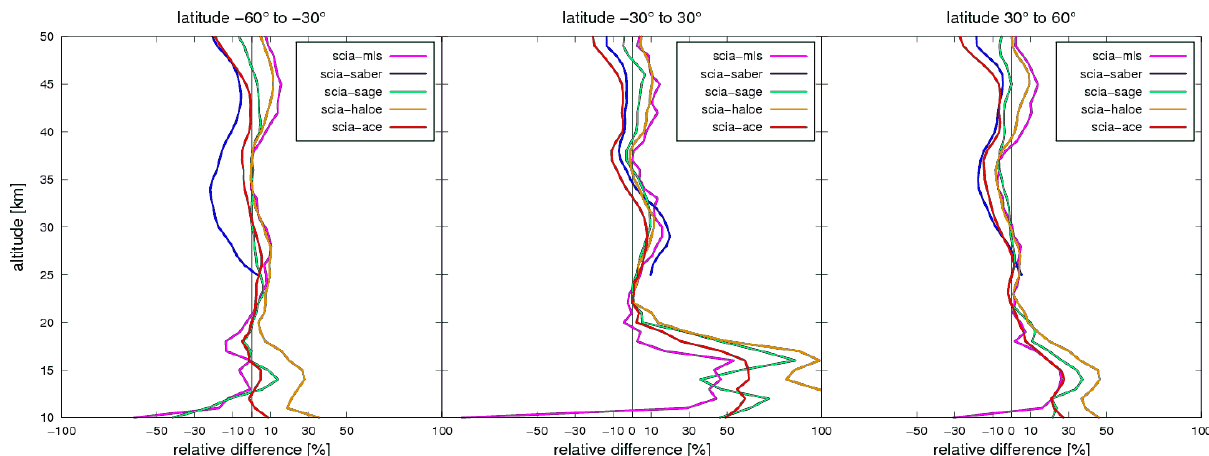
Fig. 4. From left to right: Percent differences in zonal means between SCIAMACHY ozone and other satellite data in zonal bands of